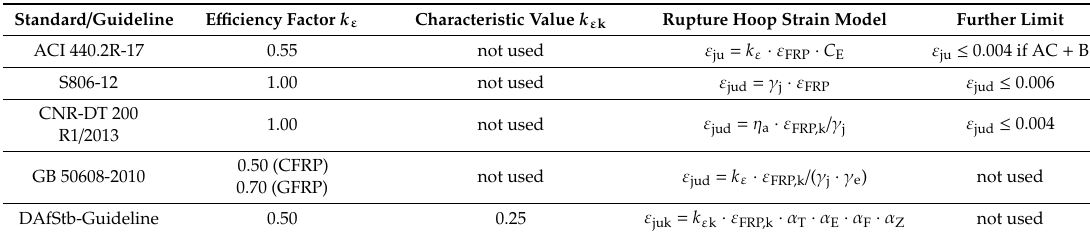
Table 4. E ffi ciency factor k ε and complementary limits for predictions of the hoop strain ε ju in FRP